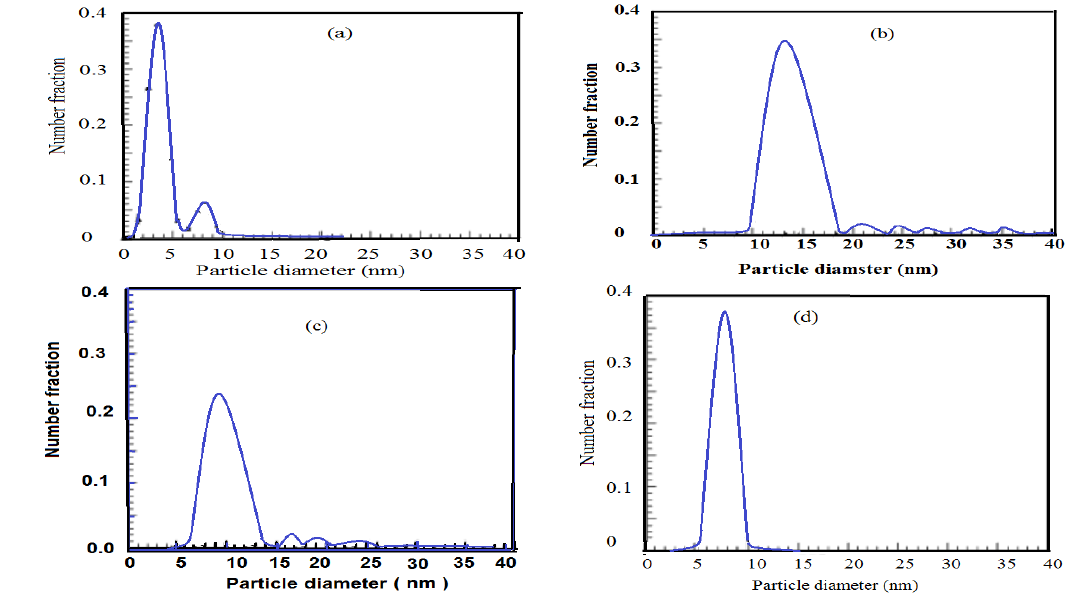
Figure 10. Particle size distribution of Ag NPs prepared with different amounts of